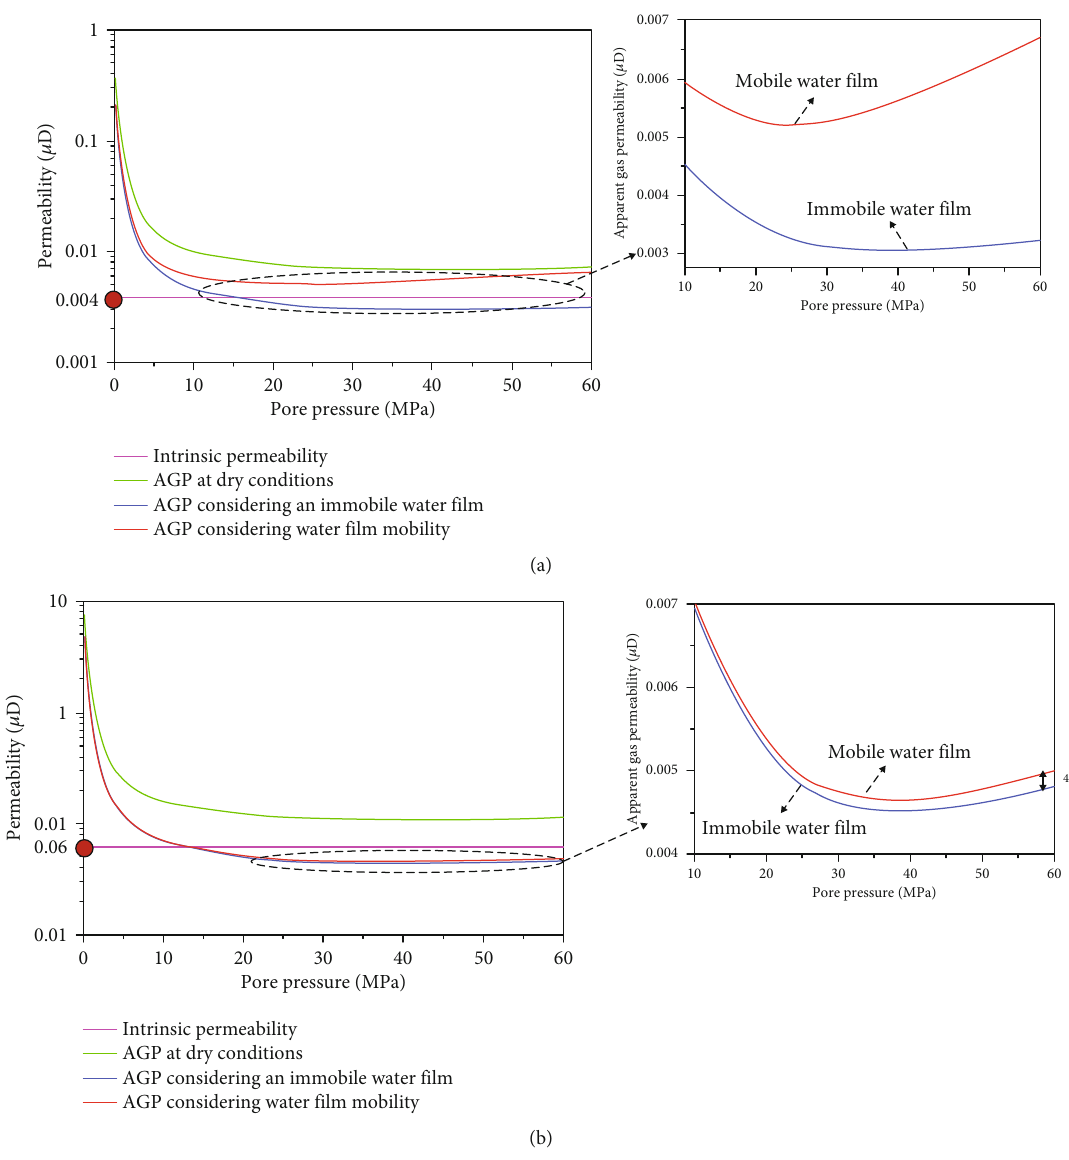
Figure 5: The gas permeability varies with pore pressure under di ff erent boundary conditions: (a) OM ( r = 10 nm, ζ = 3 , θ = 30 ° ( H 0 iOM